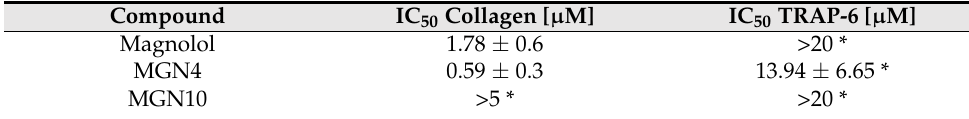
Figure 2. Platelet aggregation results . Platelet aggregation was induced by ( A ) collagen or ( B ) TRAP-6, as explained in the Methods. The aggregation assays were performed on washed platelets and the results are expressed as the percentage of aggregation after 5 min of reaction. Compounds were only tested at concentrations free of cytotoxicity. The results were obtained from at least four different donors and expressed as the mean ± SEM. Vehicle: DMSO 0.4%. The statistical analysis was performed using a one-way analysis of variance (ANOVA) and the Bonferroni post hoc test. *** p < 0.001 vs. vehicle. Table 1 . IC50 values obtained for each compound and agonist.